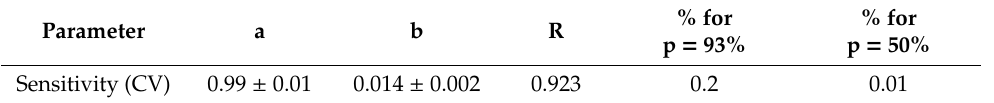
Figure 6. ( a ) ROC curve from the quantum cascade laser / support vector machine (QCL / SVM) model based on a sigmoid kernel function and ( b ) SVM detection probabilities for each concentration in all soil matrices using the SVM model. Table 4. SVM parameters for the fits and the 93% and 50% probabilities for petroleum sensing.